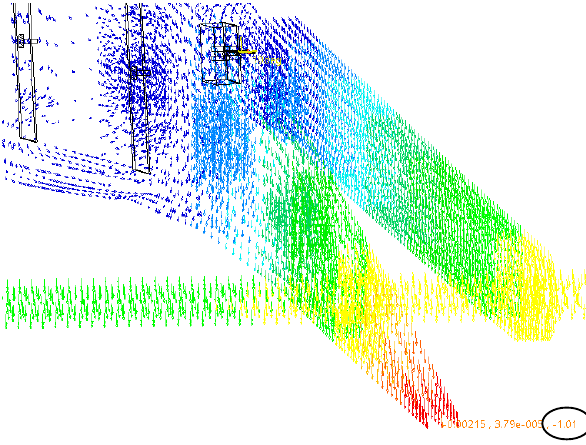
Figure 4. MTE tip displacement of 1.01 in (25.65 mm) for a 10° rotation of servomotor.